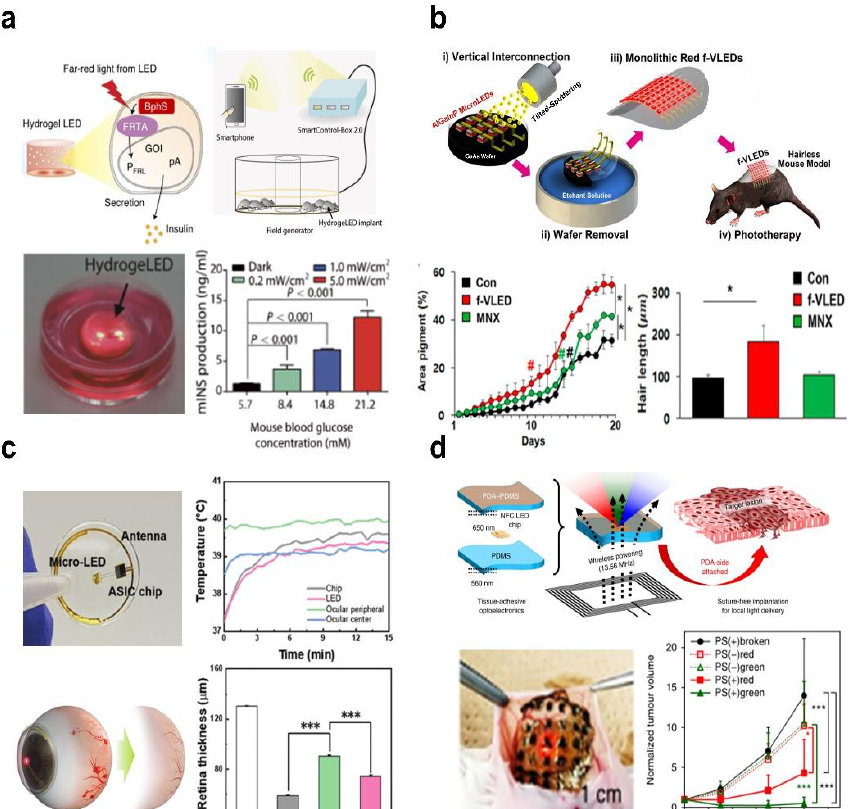
Figure 3. Microscale LEDs as implantable light sources for phototherapy. ( a ) A smart miniaturized wireless system for remotely controlling the release of glucose-lowering hormones from optically engineered cells in diabetic mice. BphS and FRTA, transcription regulators; GOI, genes of interest; pA, polyadenylation signals; P FRL , vector containing luciferase genes. Reproduced with permission from Ref. [82]. Copyright 2017, Science Translational Medicine. ( b ) Schematic illustration of trichogenic photostimulation by monolithic flexible AlGaInP vertical LEDs, with significantly improved hair-growth length and area after trichogenic treatments ( # p < 0.05, two-way ANOVA; * p < 0.05, paired t test). CON, blank control group; MNX, minoxidil (a drug that stimulates hair growth). Reproduced with permission from Ref. [83]. Copyright 2018, ACS Nano. ( c ) Contact lens with a wirelessly powered LED for the treatment of diabetic retinopathy, with significant reduction in neovascularization and retinal hemorrhage following photobiomodulation therapy (*** p < 0.0005, paired t test). DR, diabetic retinopathy; OD, LED treatment; OS, without LED treatment. Reproduced with permission from Ref. [84]. Copyright 2022, Advanced Science. ( d ) Metronomic photodynamic therapy employs tissue-adhesive, wirelessly powered LEDs to activate photosensitizers and generate singlet oxygen for treatment (* p < 0.05, *** p < 0.001, Tukey’s honestly significant difference test). PS(+), add photosensitizer; PS (−), without photosensitizer. Reproduced with permission from Ref.